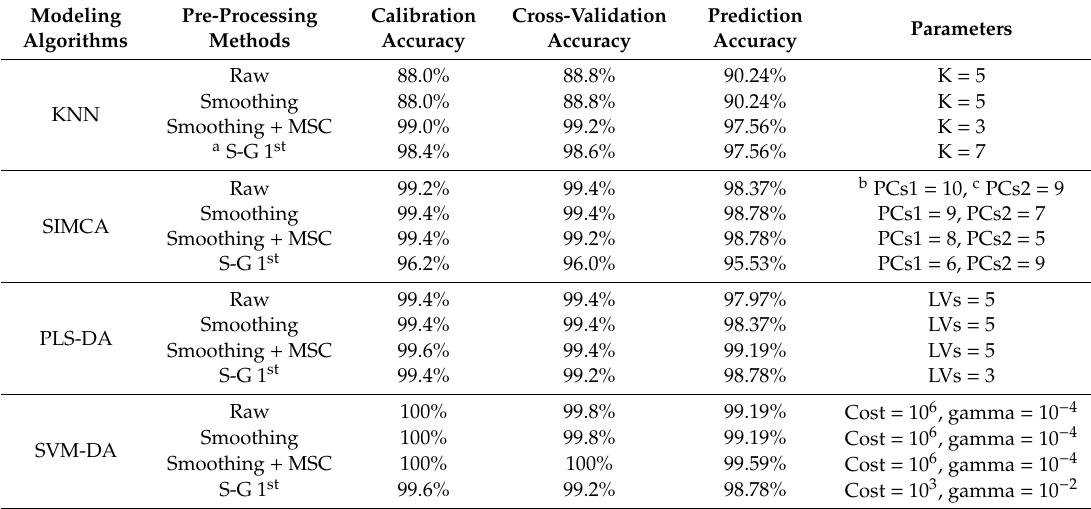
Table 2. Comparison of the classification results of four models coupled with di ff erent pre-processing methods built on full-range wavelength